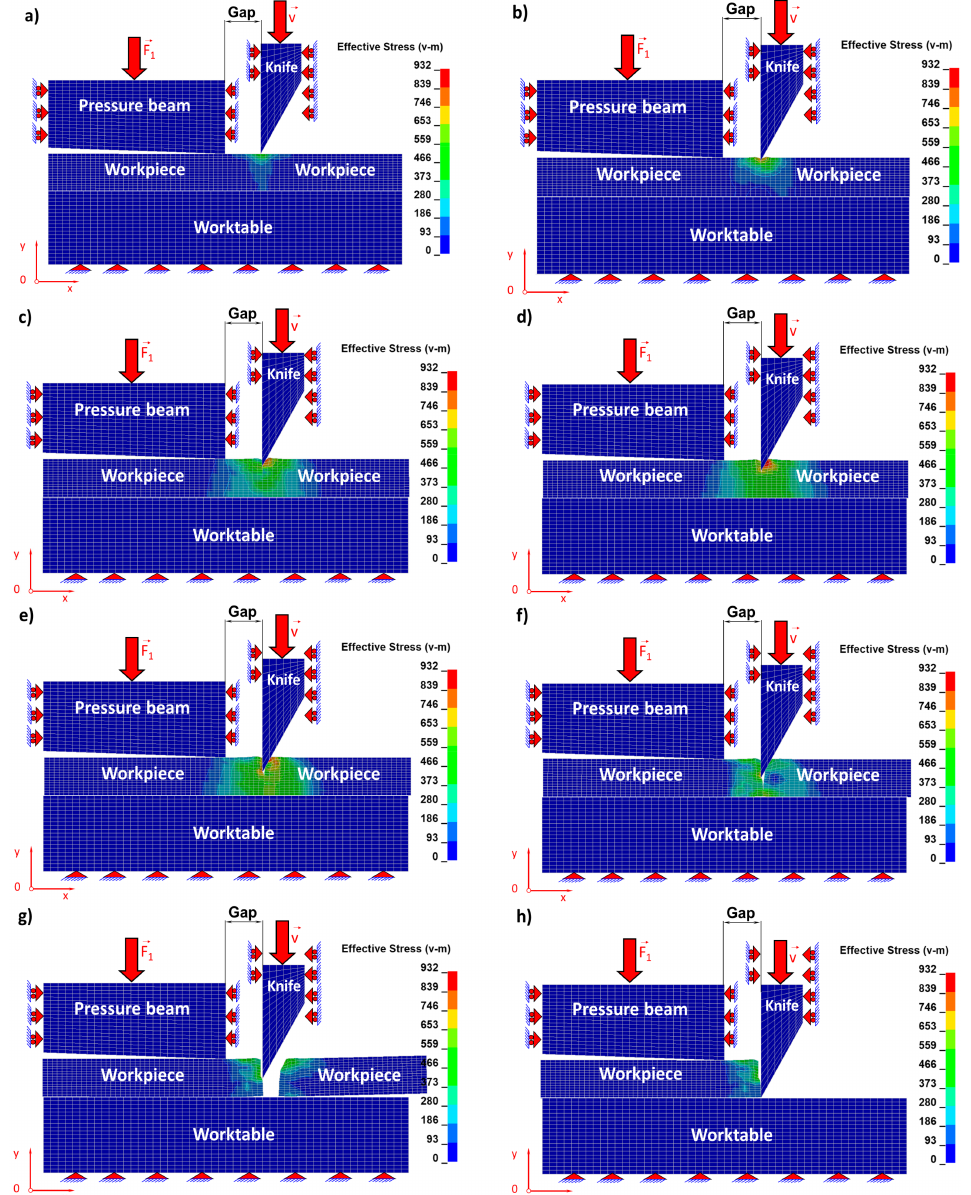
Figure 6. Individual stages of reduced Huber–Mises stresses during numerical simulation of a cutting process for selected time instants: ( a ) t a = 2.07 s; ( b ) t b = 3.0 s; ( c ) t c = 4.0 s; ( d ) t d = 5.0 s; ( e ) t e = 6.0 s; ( f ) t f = 7.1 s; ( g ) t g = 7.2 s; ( h ) t h = 12.0